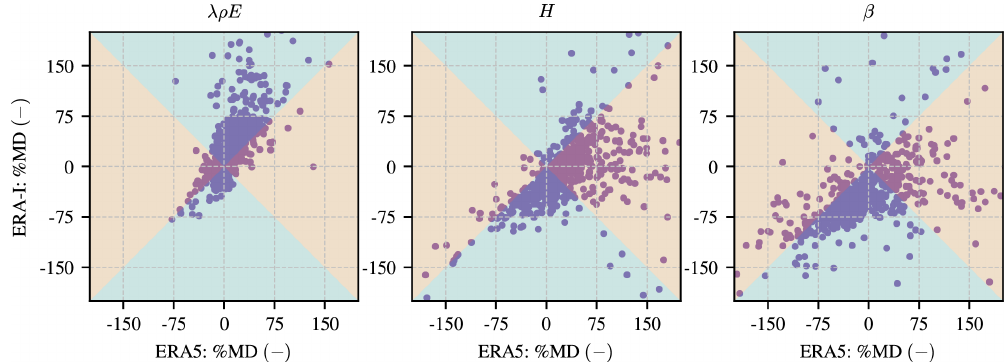
Figure 6. Scatter plot of the bias of the surface latent heat flux ( λρE ), surface sensible heat flux ( H ), and Bowen ratio ( β ) from ERA-I vs. ERA5. The bias is calculated against catchment-scale estimates of the fluxes derived using discharge data (Eqs. 1–3) and is assessed by the percentage of mean difference (%MD, raw time series from 707 catchments as reference). The green area indicates points where the bias in ERA5 is better than that in ERA-I, and vice versa for the brown